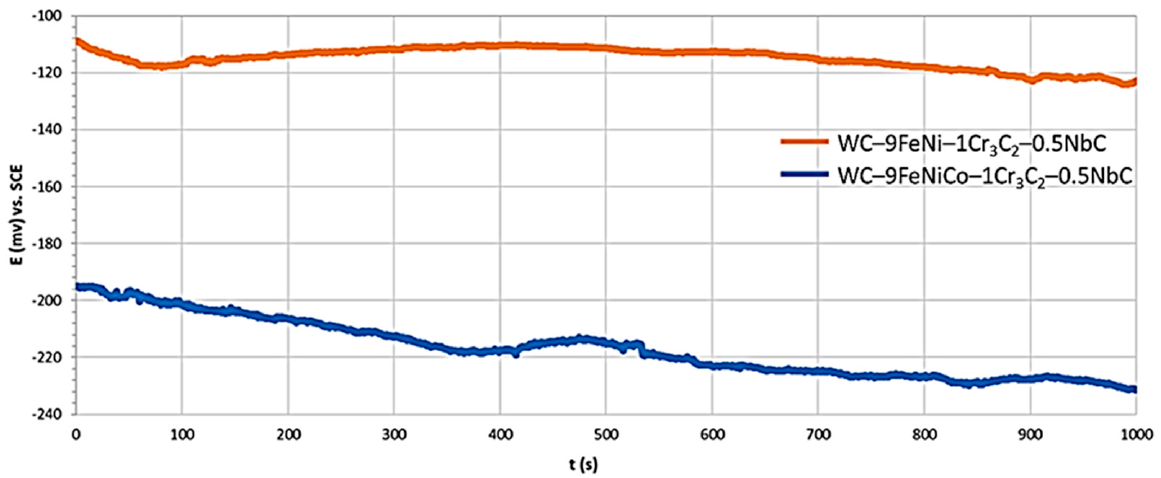
Figure 6. Open circuit potential ( E corr ) versus time curves of samples.